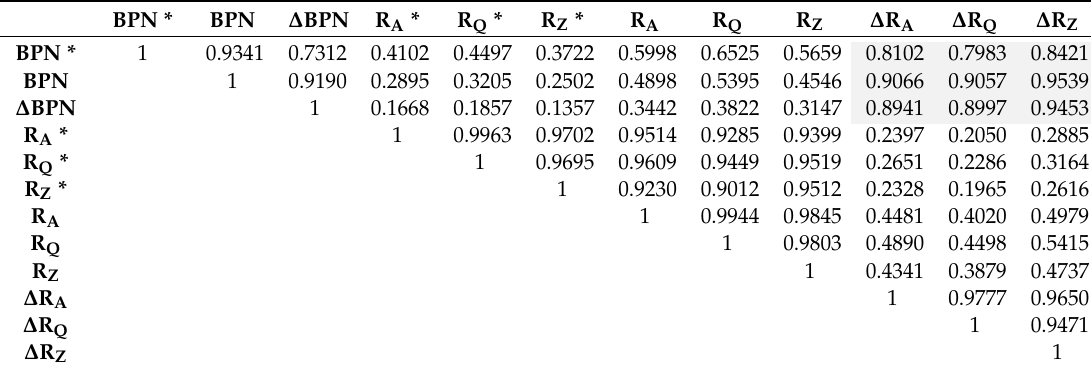
Table 7. Correlation coe ffi cient R 2 between superficial friction and roughness parameters.